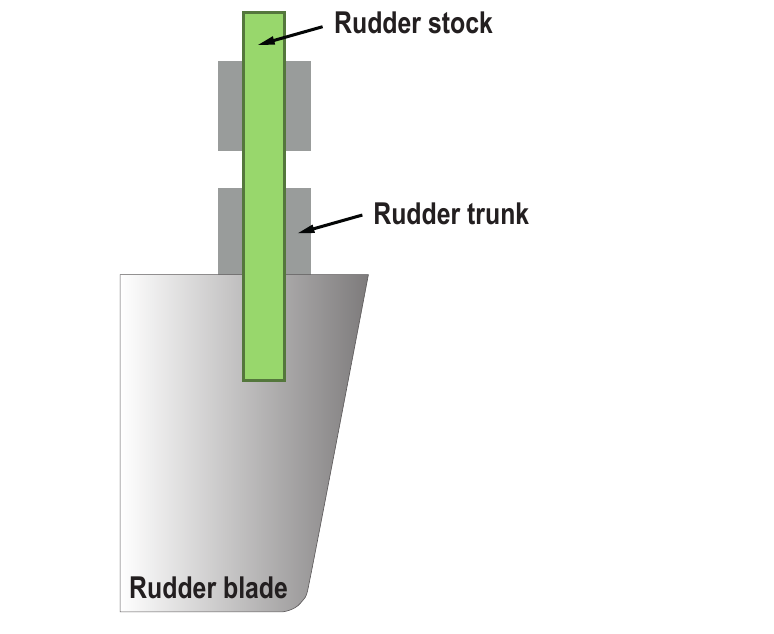
Figure 1. Illustration of the rudder stock as part of the rudder